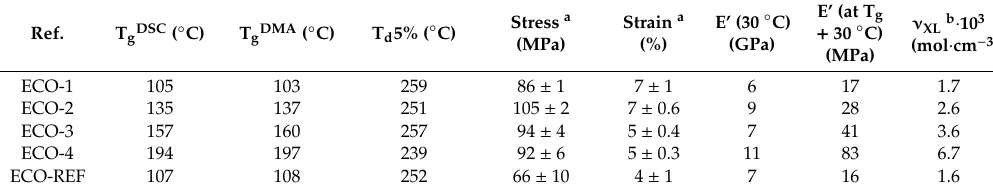
Table 2. Thermomechanical properties of the prepared